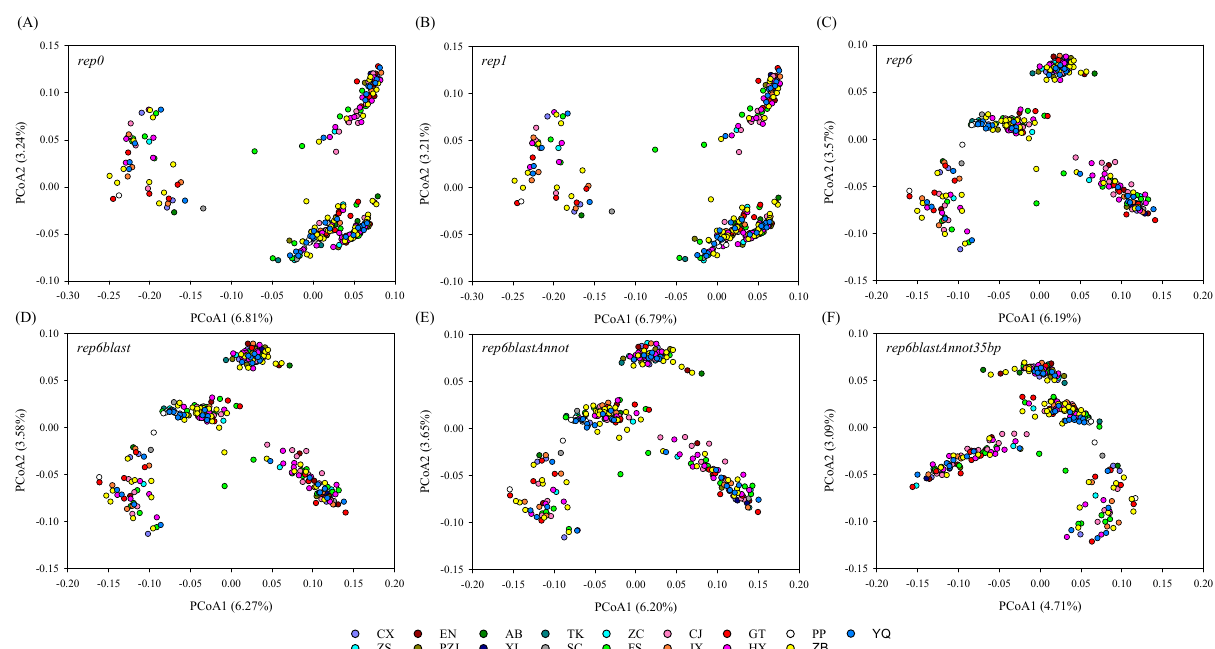
Figure 4. PCoA plots of 299 Masson pines based on the SNPs obtained without or with replicates in different filtering scenarios from zero to six pairs. Panels ( A ) to ( F ) were the PCoA plots for SNPs of rep0 (443,571) ( A ), rep1 (435,039) ( B ), rep6 (153,942) ( C ), rep6blast (134,611) ( D ), rep6blastAnnot (60,143) ( E ), and rep6blastAnnot35bp (20,055) ( F ). The different signals of colored circles with the related abbreviations represent the original resource of subpopulations from four local populations displayed in Table S1.